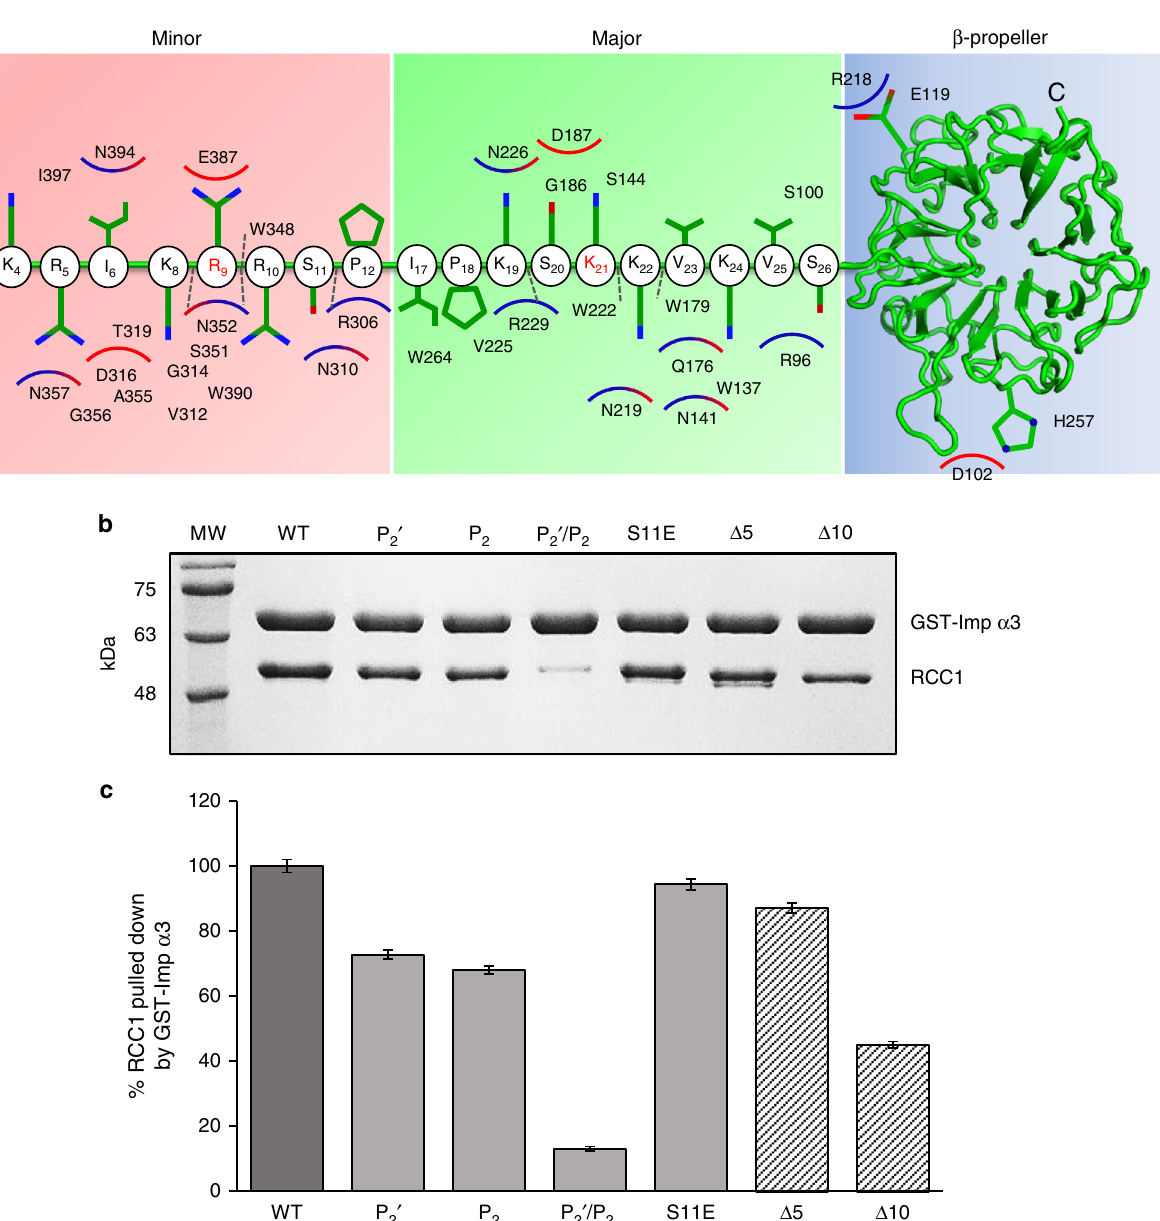
Fig. 3 Importin α 3:RCC1 binding interface. a Schematic diagram of interactions between RCC1 and importin α 3. R9 and K21 at positions P 2 ′ and P 2 , respectively, are shown as red letters. b Pull-down analysis of the interaction of GST- Δ IBB-importin α 3 immobilized on glutathione beads with RCC1. Loading controls are in Supplementary Fig. 3a c Quanti fi cation of pull-downs shown as mean ± SD for three independent experiments. No interaction is observed between free RCC1 and glutathione beads (Supplementary Fig.